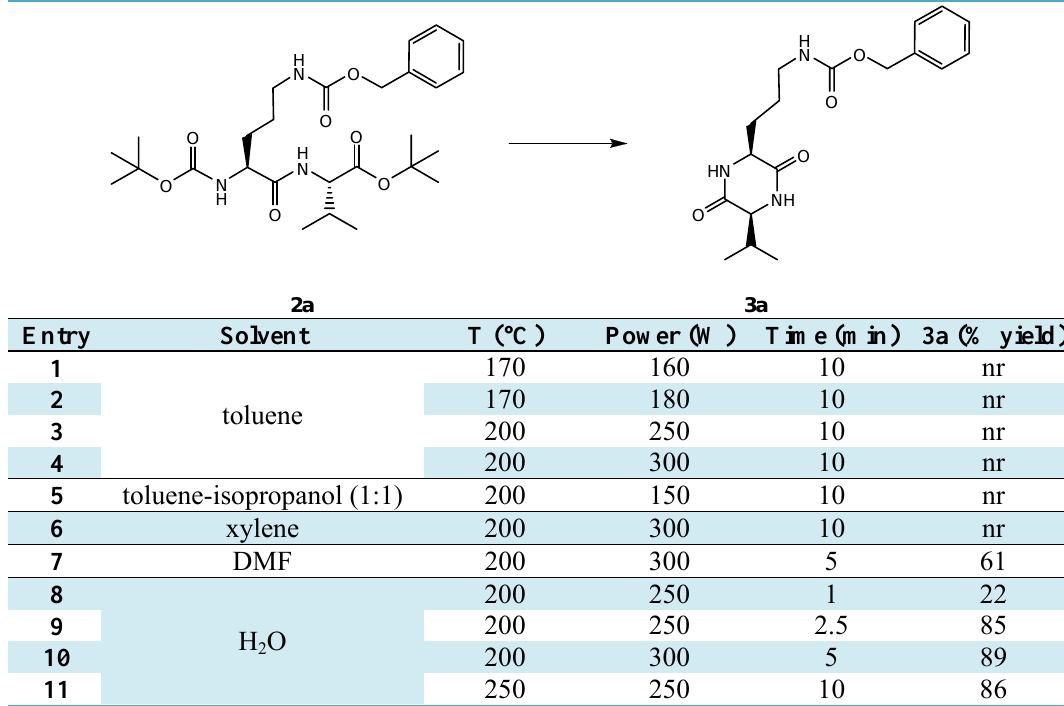
Table 1. Cyclization of dipeptide 2a to diketopiperazine 3a under microwave irradiation.